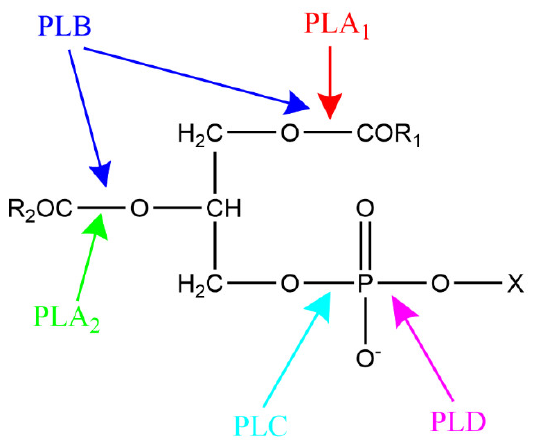
Figure 6. The acting sites of phospholipases. Phospholipase A (PLA) cleaves the ester bond at either the sn − 1 position (phospholipase A 1 , PLA 1 ) or the sn − 2 position (phospholipase A 2 , PLA 2 ). Phospholipase B (PLB) hydrolyzes the ester bond at both the sn − 1 position and sn − 2 position. Phospholipase C (PLC) cleaves the phosphodiester bond at the glycerol backbone, while phospholipase D (PLD) removes the polar head group (X) of PLs.